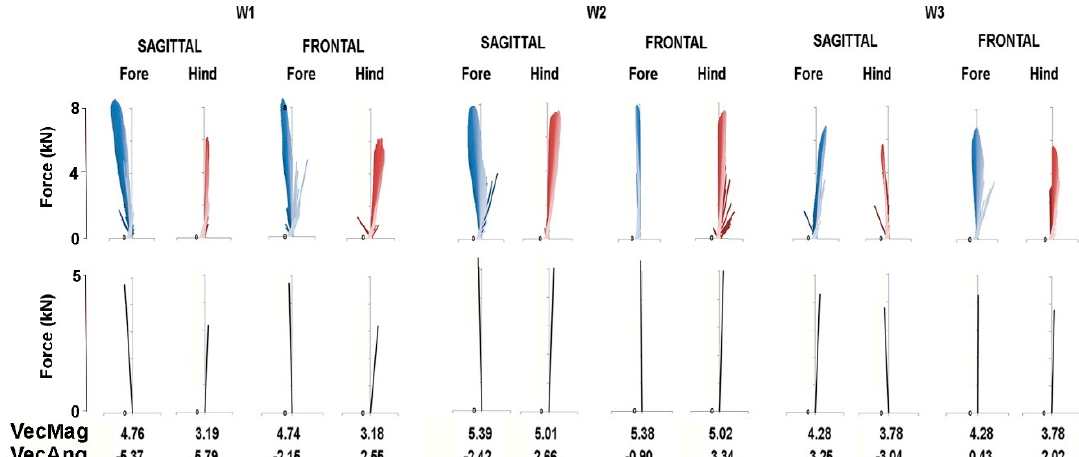
Figure 6. Force vector diagrams (upper panel) of Warmblood horses for the same stance phases as in Figure 3. In the sagittal plane vector diagrams, propulsive longitudinal forces are positive to the right. In the frontal plane vector diagrams, medially directed transverse forces are positive. Summary vectors derived from each vector diagram are shown in the lower panel together with the values for the mean vector magnitude (VecMag) and mean vector angle (VecAng).